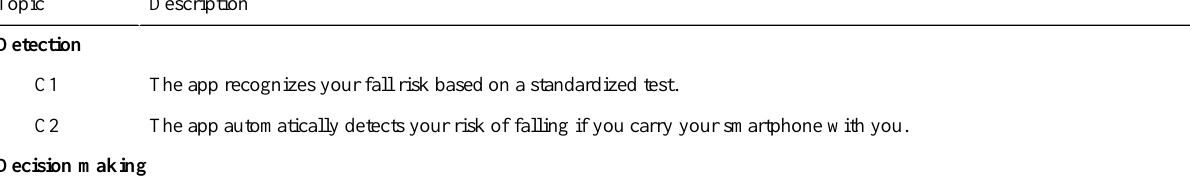
Table 1. Investigated product features of a fall prevention app. C: criteria.